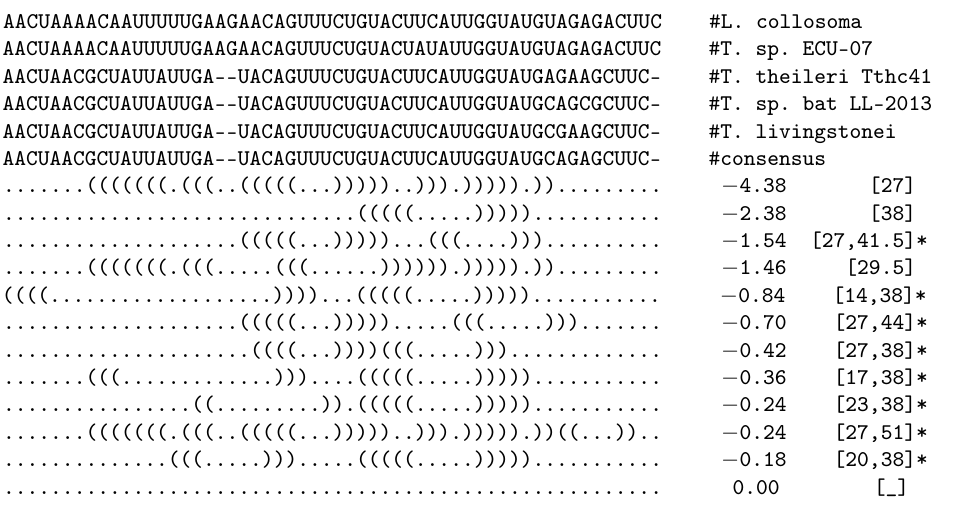
Figure 1. Consensus hishapes for the alignment of five SL RNA sequences. Hishapes marked with ‘*’ would not show up when using the pseudo free energy filter ‘ -x 0 ’, which does not allow substructures with positive pseudo free energy in the external loop.